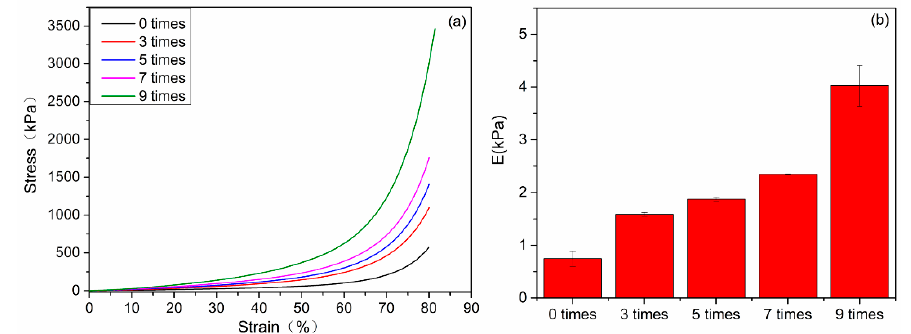
Figure 6. ( a ) The compression stress ‒ strain curves and ( b ) Young’s modulus of the CDs 3.0 /HA 0.6 /PVA DN hydrogels with 0, 3, 5, 7, and 9 freezing/thawing cycles, respectively.